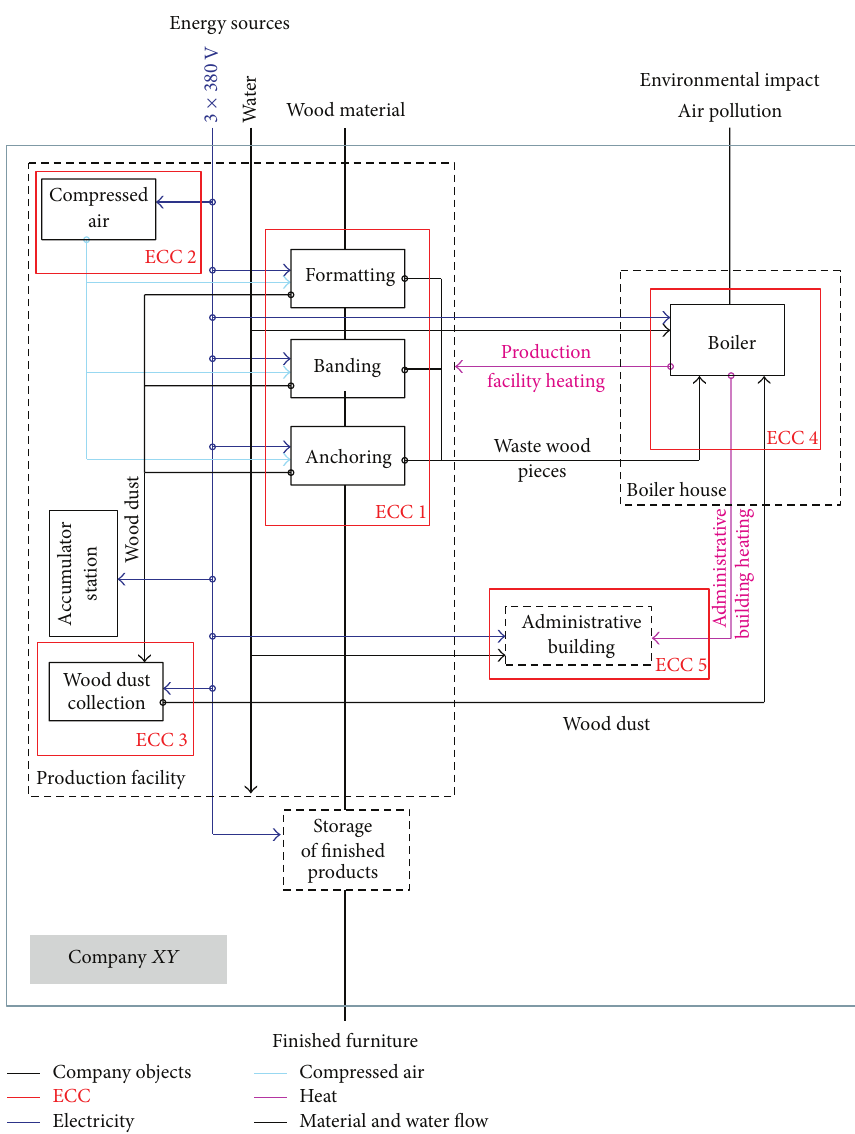
Figure 5: ECCs in a company XY which produces furniture from wood-based board